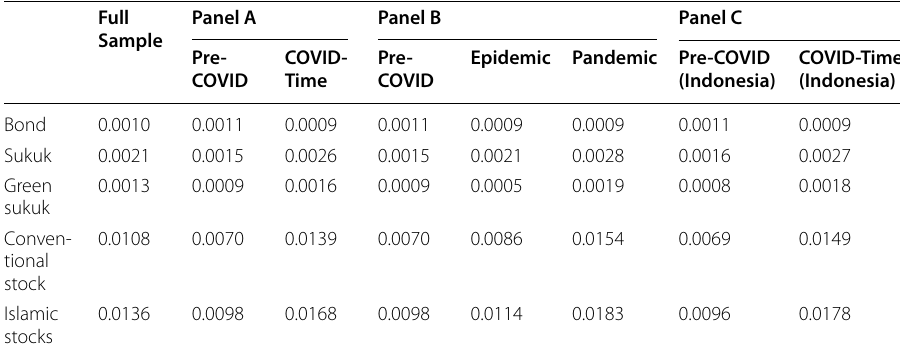
Table 2 Average sample volatility of